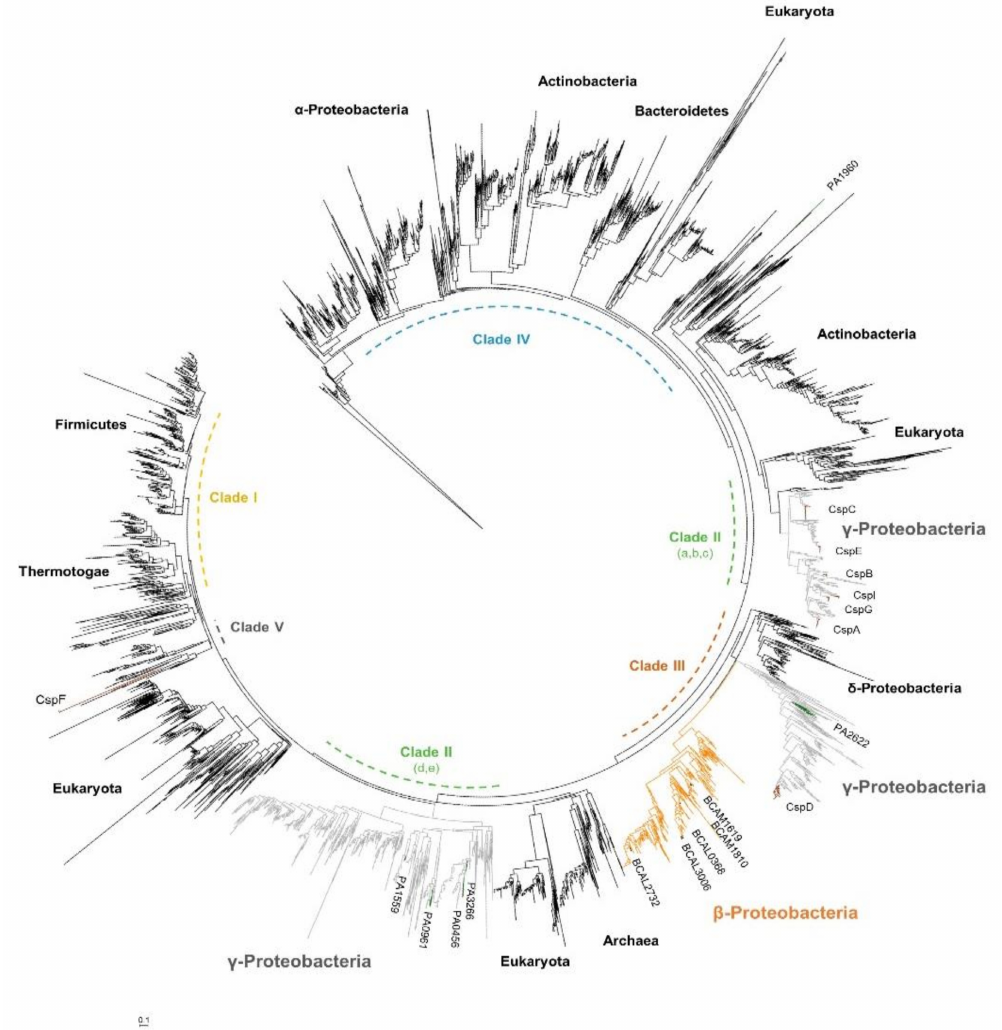
Figure 4. Phylogenetic tree for cold shock proteins of all domains of life. The phylogenetic tree was inferred for the alignment of 4636 non-redundant cold shock protein sequences (annotated with the reference COG1278) from 1436 species. The tree was drawn to scale using the iTol v5 software [45], with branch lengths measured in number of substitutions per site. The groups containing cold shock proteins from γ or β -proteobacteria are colored, respectively, in grey or orange. Cold shock proteins (Csps) from E. coli are highlighted in brown and from P. aeruginosa in green. The five main clades recently defined by Yu and co-authors are highlighted